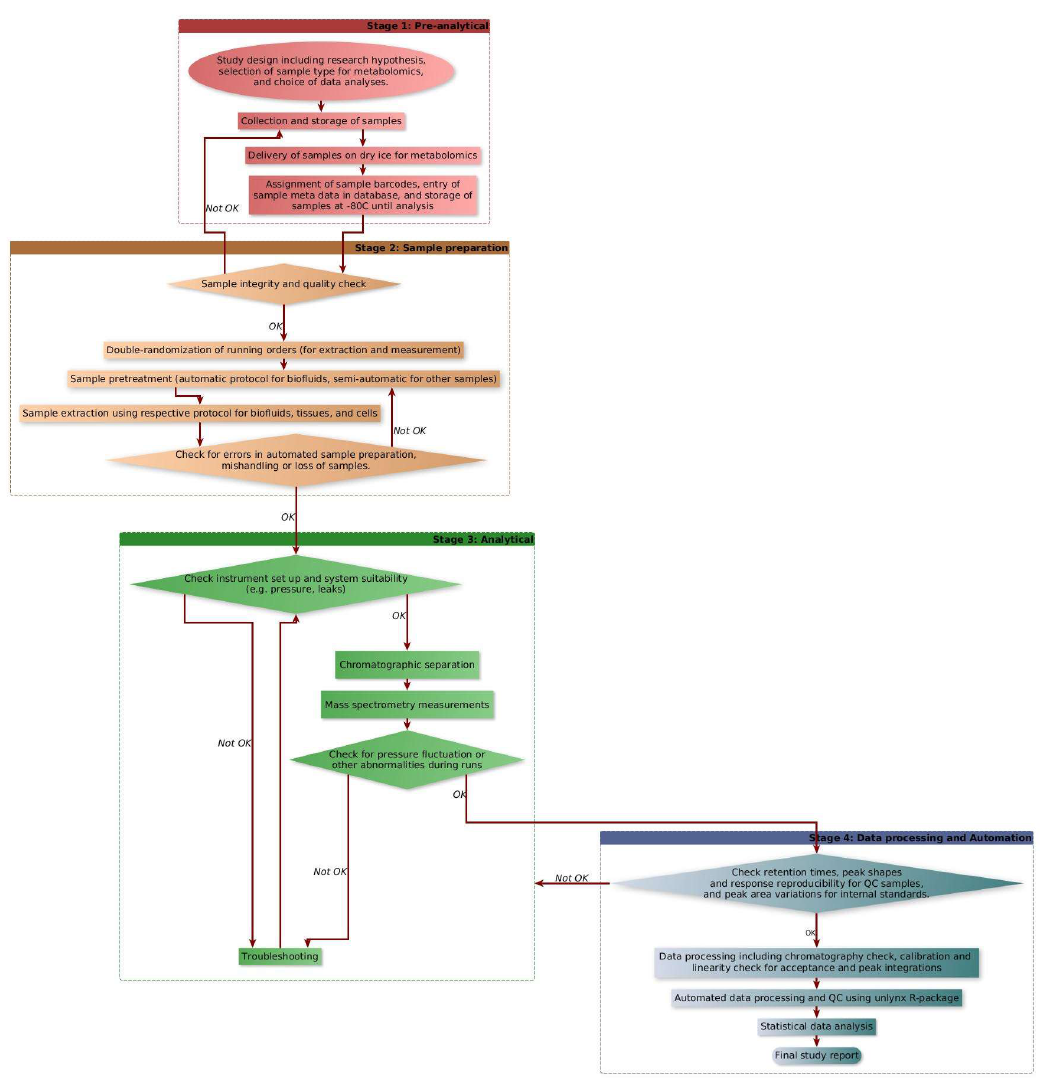
Figure 1 . A flowchart describing preanalytical stage, sample treatment and analysis, analytical stage, automation, and quality checks.